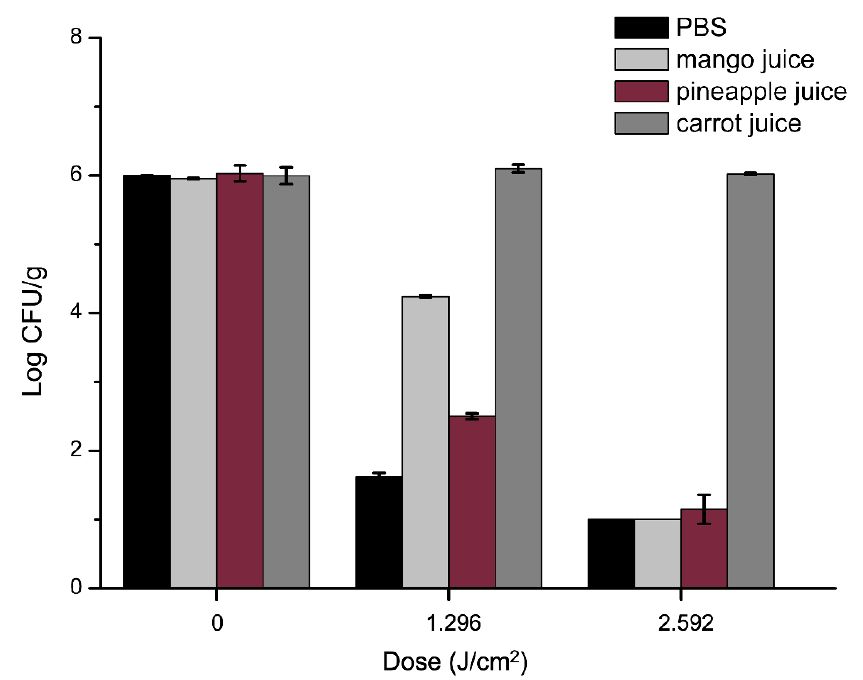
Figure 7. Effect of the curcumin-based aPDT against S. aureus in mango, pineapple, and carrot juice at 10 µ M curcumin with 1.296 and 2.592 J/cm 2 light dose. Samples of PBS were used as control.